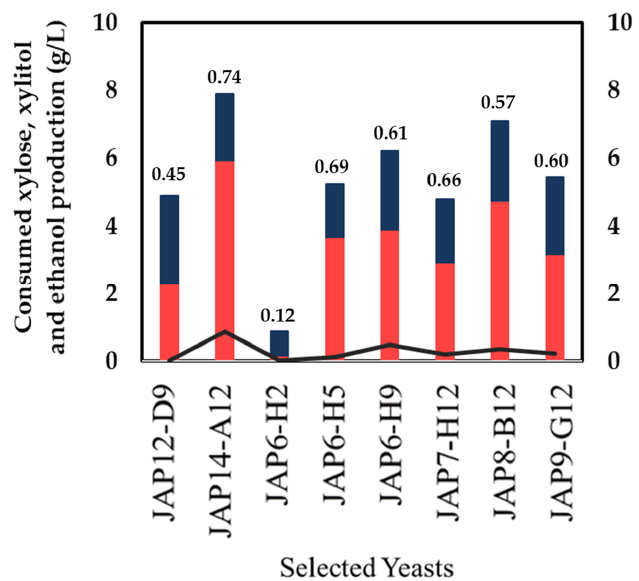
Figure 4. Xylose consumption and xylitol production in a defined medium supplemented with xylose (40 g / L), inoculated at a high cellular density condition, by the eight yeasts previously selected. The yield (g xylitol / g xylose consumed) is represented by the numbers on the top of the columns. Xylose consumption (grey bars); xylitol production (black bars); ethanol production (light grey line).